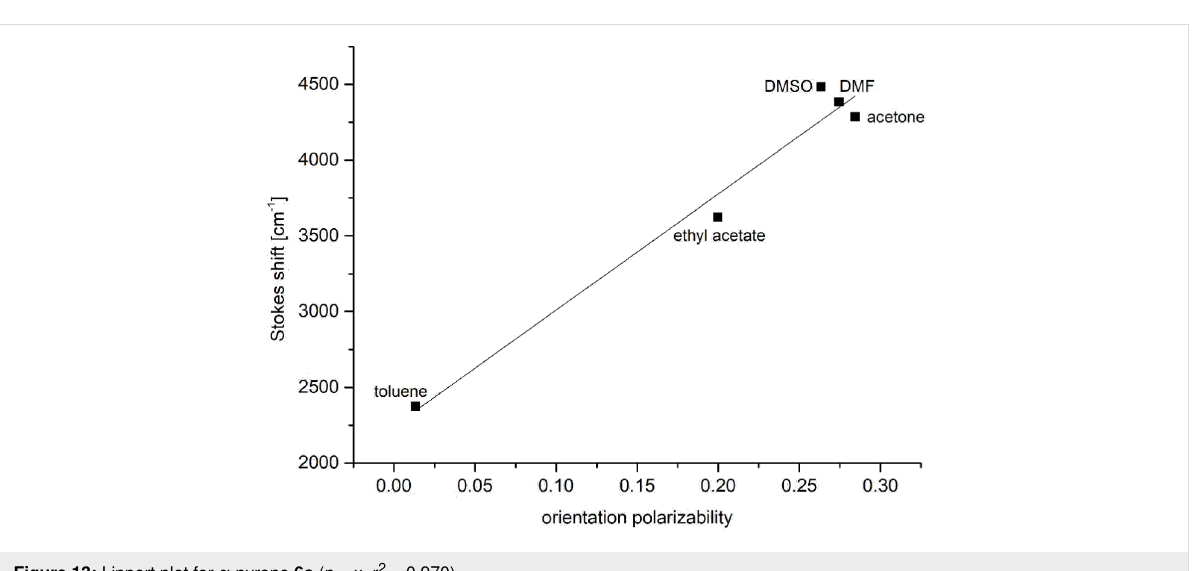
excited and ground state (in C·m), ε 0 (8.8542·10 − 12 A·s/V·m)